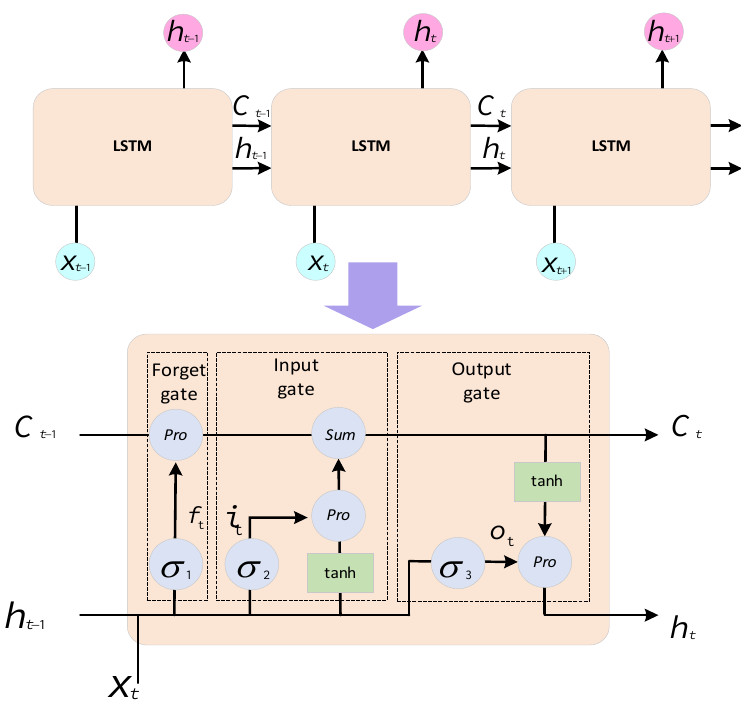
Figure 7. The structure of LSTM.